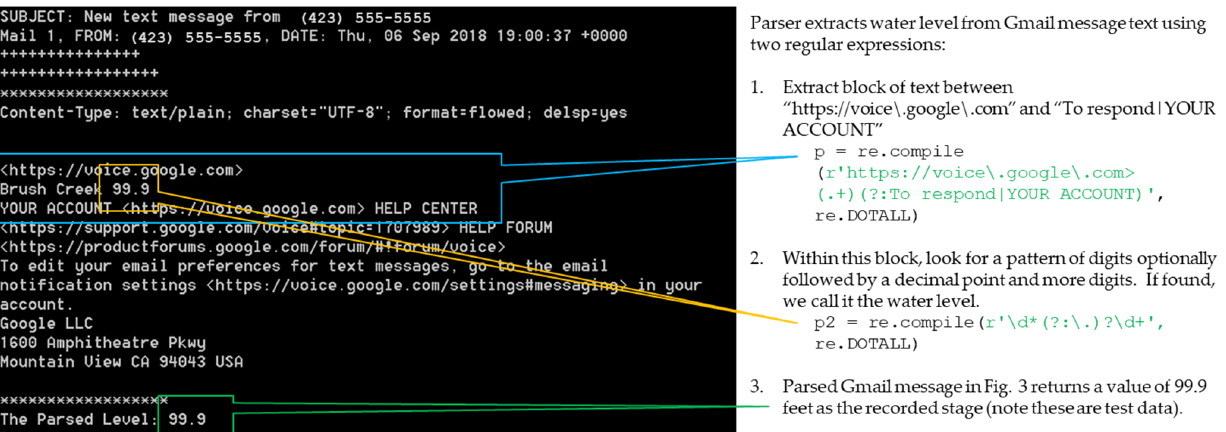
Figure 3. Parser code and description of parsing process.